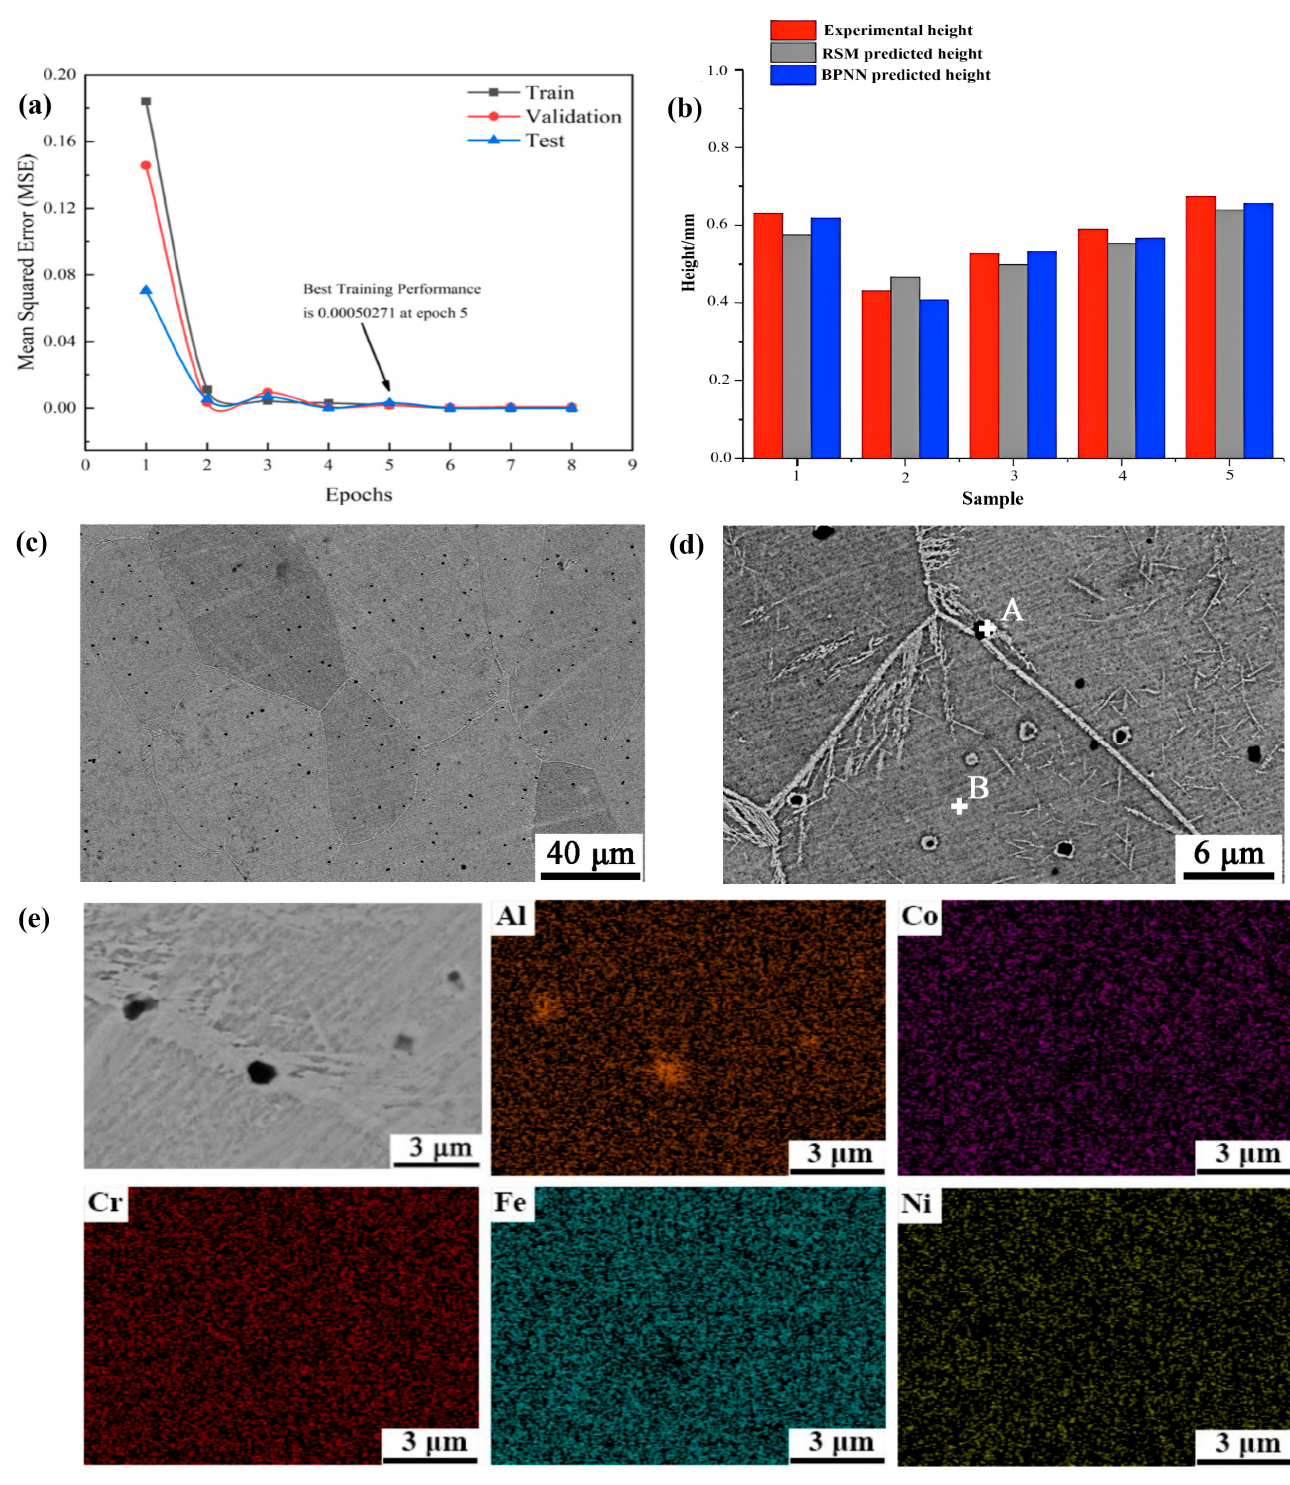
Figure 6. The BP neural network training process, the comparison between the BP neural network model and the RSM model prediction results, and the microstructure of AlCoCrFeNi HEA coatings under optimal process parameters. ( a ) The BP neural network training process. Reprinted from [118]. ( b ) Comparison of the prediction results of neural networks and RSM for clad height. Reprinted with permission from Ref. [117]. 2020, Elsevier. ( c ) Back-scattered SEM images of the AlCoCrFeNi coating microstructure under low magnification [118]. ( d ) Back-scattered SEM images of the AlCoCrFeNi coating microstructure under high magnification. At the region marked B in ( d ), the Fe element content was the highest, which was 30.40 at.%; and the Al element content was the low- est, which was 14.98 at.%. The black granular microstructure (marked A) had the highest content of